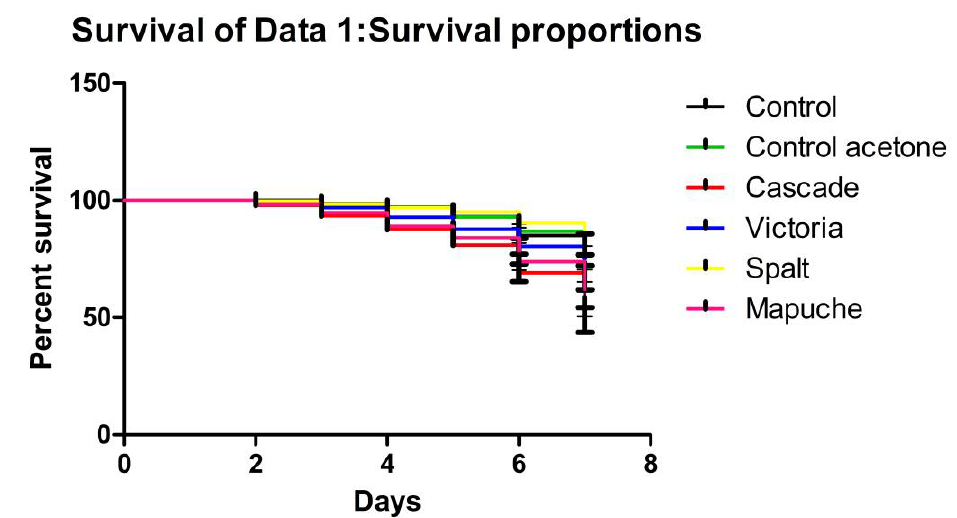
Figure 1. Kaplan—Meier plot of honey bee larvae survival function on different treatment: Control Figure 1. Kaplan — Meier plot of honey bee larvae survival function on different treatment: Control with no solvent (Control), control with solvent (Control acetone), hydrolats of Cascade variety with no solvent (Control), control with solvent (Control acetone), hydrolats of Cascade variety (Cas- (Cascade), hydrolats of Victoria variety (Victoria), hydrolats of Spalt variety (Spalt), and hydrolats cade), hydrolats of Victoria variety (Victoria), hydrolats of Spalt variety (Spalt), and hydrolats of of Mapuche variety (Mapuche). The varieties that differed from the control are Cascade (Log-rank Mapuche variety (Mapuche). The varieties that differed from the control are Cascade (Log-rank Figure 1. Kaplan — Meier plot of honey bee larvae survival function on different treatment: Control (Mantel–Cox) Test p < 0.0001) and Mapuche (Log-rank (Mantel–Cox) Test p = 0.0015). (Mantel--Cox) Test p < 0.0001) and Mapuche (Log-rank (Mantel--Cox) Test p = 0.0015). with no solvent (Control), control with solvent (Control acetone), hydrolats of Cascade variety (Cas- cade), hydrolats of Victoria variety (Victoria), hydrolats of Spalt variety (Spalt), and hydrolats of When analyzing the weights of larvae on the last day of the experiment, no differences Mapuche variety (Mapuche). The varieties that differed from the control are Cascade (Log-rank were found between the weights, except for the Spalt variety, which was higher than the (Mantel--Cox) Test p < 0.0001) and Mapuche (Log-rank (Mantel--Cox) Test p = 0.0015). control (Figure 2).